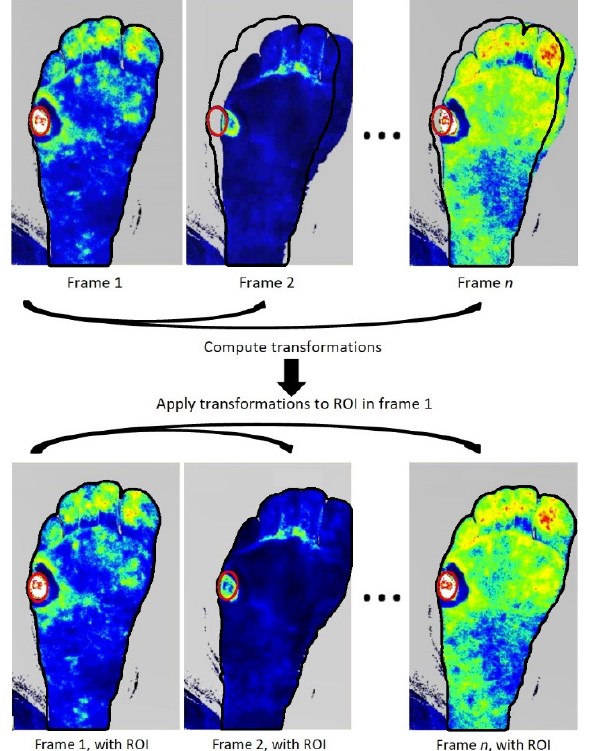
Figure 3. Principle of the region of interest (ROI) tracking. The transformation from frame 1 towards the other frames is computed based on the shape of the foot in both frames. The ROI in the frames [2, n] is computed by application of the transformation from frame 1 to frame n on the initial ROI. If, as shown, the foot moves to right, the ROI follows correct placement at the ulcer location.